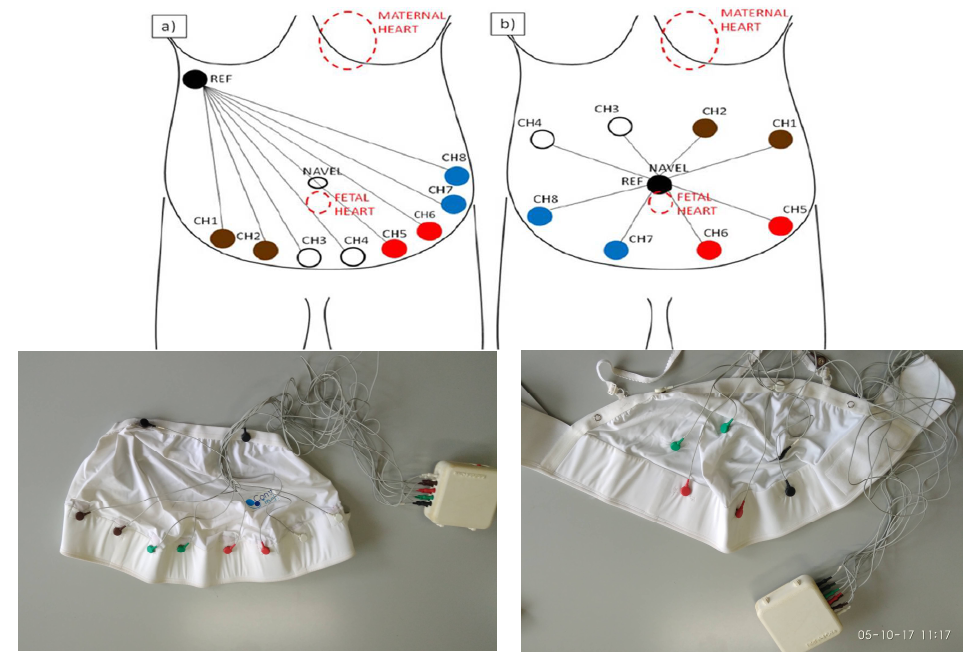
Figure 2. Relative positioning of the electrodes on the mother abdomen ( above ) and their configuration on the elastic bodysuit ( below ).